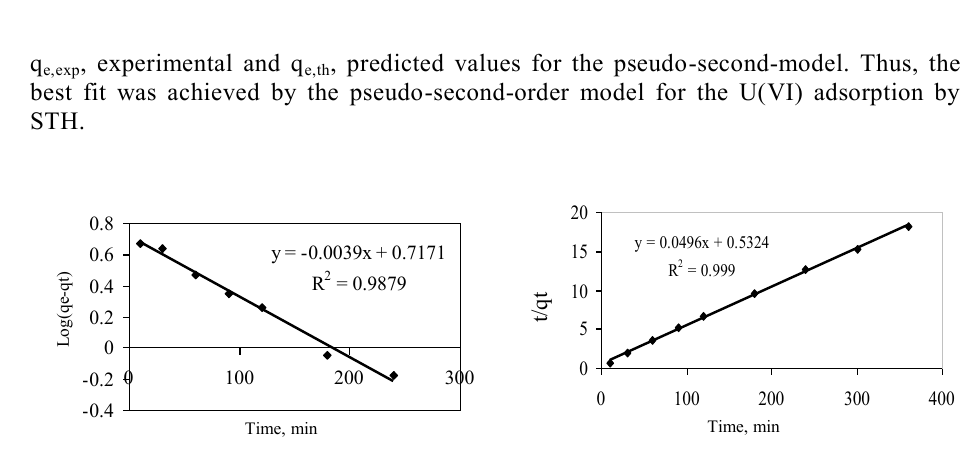
Figure 5. Plots of pseudo-first-order equation for U(VI) adsorption ([U] = 20 mg/L, pH=6.5, T=303K).